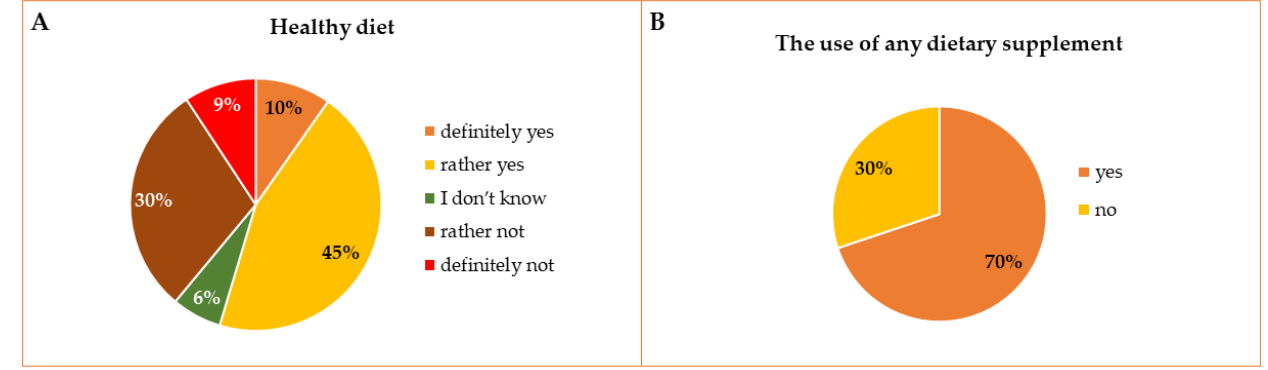
Figure 2. Declared type of diet ( A ), the overall use of any dietary supplements in the group of respondents ( B ).